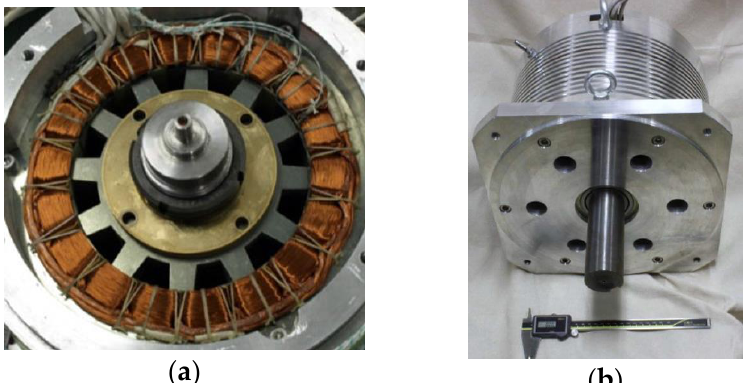
Figure 8. Switched reluctance machine (SRM) proposed for traction application in [30]: ( a ) rotor inside the stator; ( b ) assembled motor [29]. This motor was designed to match performance of the 2003 Toyota Prius traction motor.